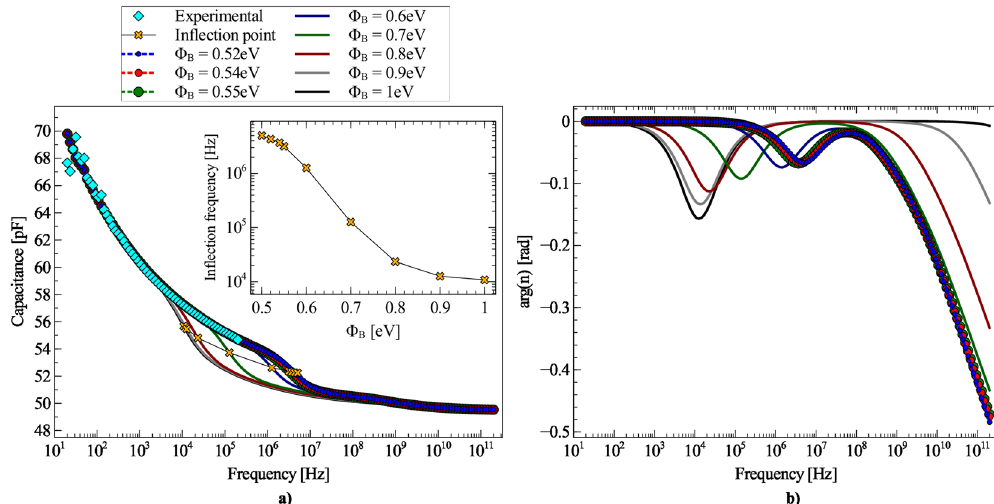
Figure 4. Results of Drift–Diffusion simulations of the MIS device in the high accumulation regime (V_ g = + 35 V), for different values of the injection barrier Φ B . ( a ) CF curves. The inset shows the dependence of the inflection frequency on Φ B . Experimental CF characteristics shown for comparison (cyan diamonds). ( b ) Phase of the carrier density at the semiconductor/insulator interface ∠ n